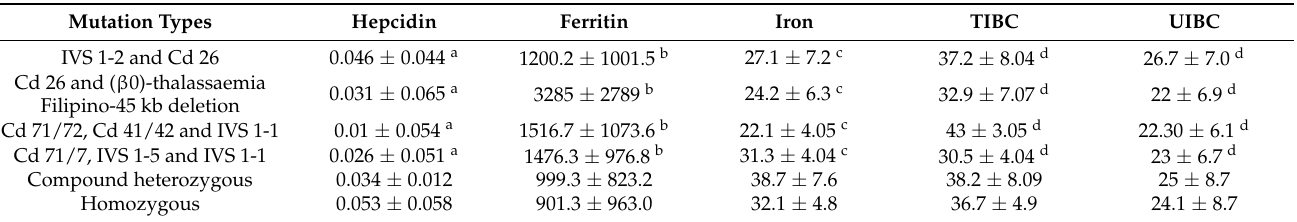
Table 7. Biochemical characteristics according to the mutation types of HbE/ β -thalassaemia